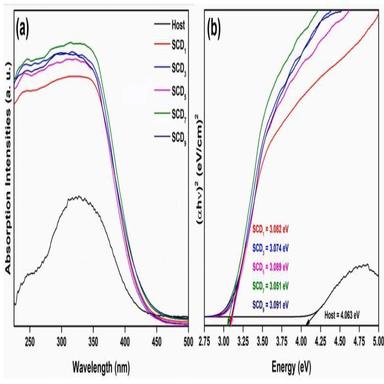
UV spectra (a) along with Tauc's plot evaluating band gap energy (b) of host and SCDx NPs (x = 1–9 mol%).